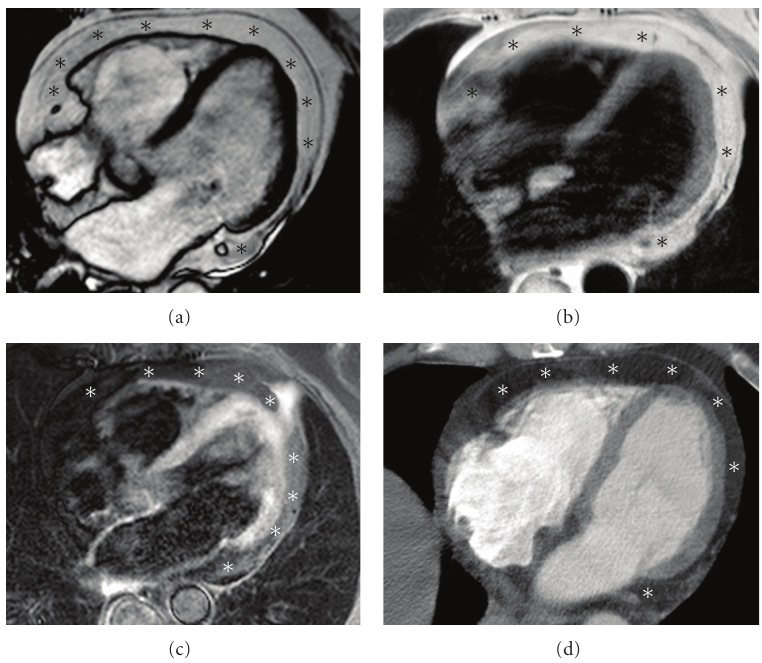
Figure 5: Epicardial fat. Echocardiography raised concerns about excessive soft tissue anterior to the right ventricle in this patient on long-term steroids. Bright blood cine (a) and T1-weighted images (b) show circumferential high signal around the heart (asterisks). The appearances suggest an unusual amount of pericardial fat, and this was confirmed on fat-suppressed CMR (c) where there is evidence of signal drop out from the fatty region (asterisks—compare with (b)). MDCT is also very sensitive for fat which it displays as low-density regions of negative Hounsfield attenuation ((d), asterisks). Excessive mediastinal lipomatosis is not uncommon in patients taking steroid